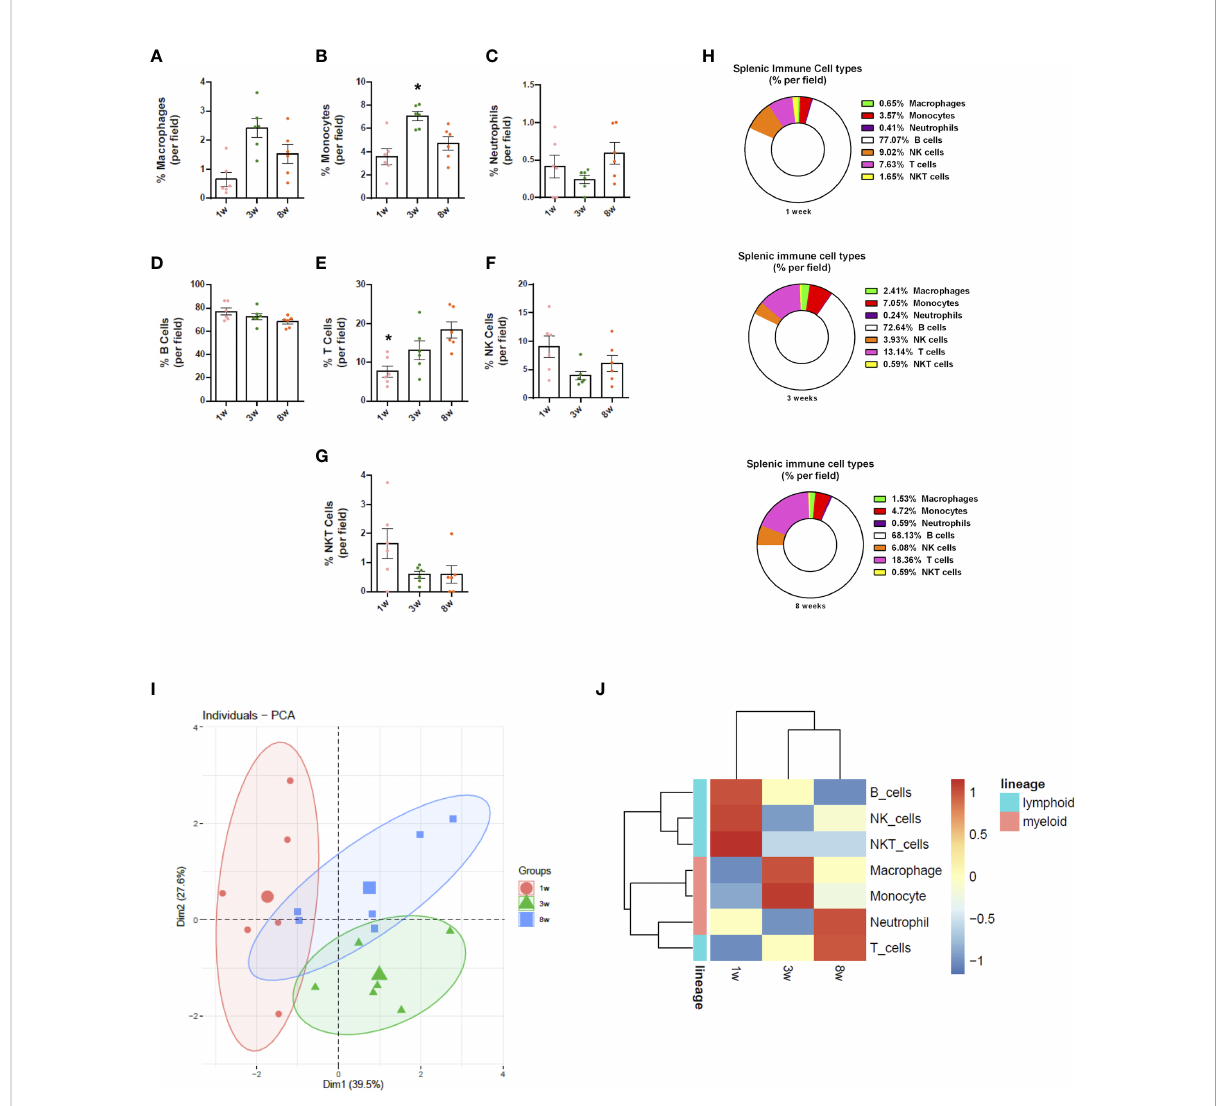
FIGURE 4 Splenic immune cell composition changes throughout life. Images from spleen confocal microscopy were manually quanti fi ed (n = 6/group; 3 fi elds per animal). (A-H) Differential expression of markers and cell morphology were analysed to de fi ne immune cell populations, which were quanti fi ed in frequency (% of total). (I) PCA analyses plot of the data obtained from the three groups evaluated. (J) Heatmap representation of the chronological dynamics of immune populations, clustered by cell-lineages. *p <0.05 compared to the adult mouse group (8 weeks). One- way ANOVA. NK, natural